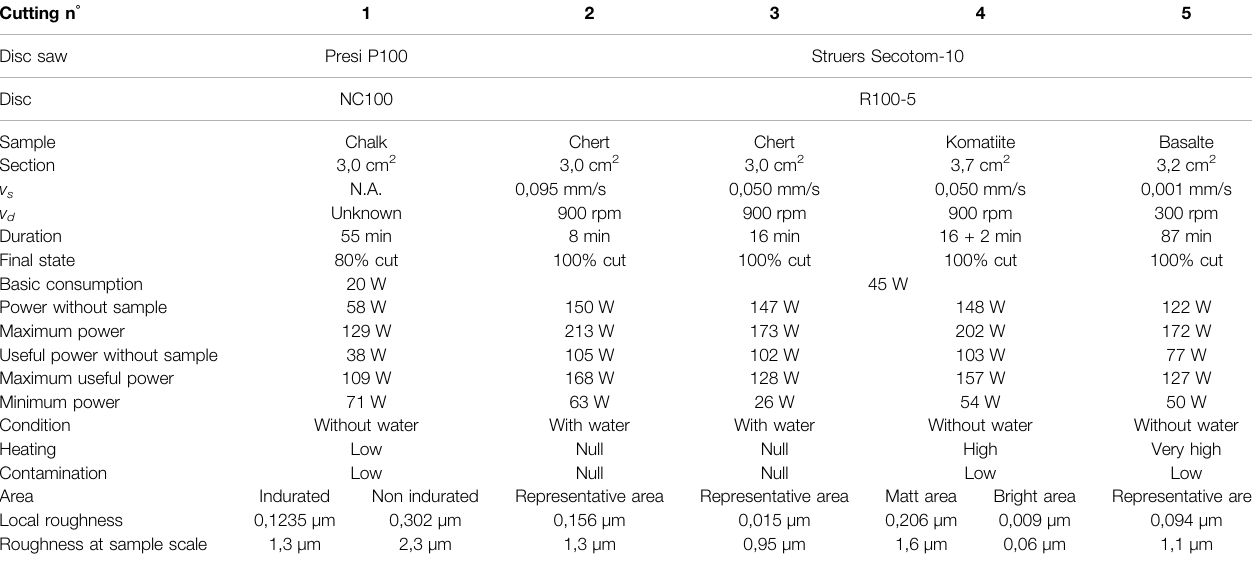
TABLE 2 | Summary table of the various parameters and results associated with each cut ( v s : sample displacement speed; v d : disc rotation speed). Cutting n